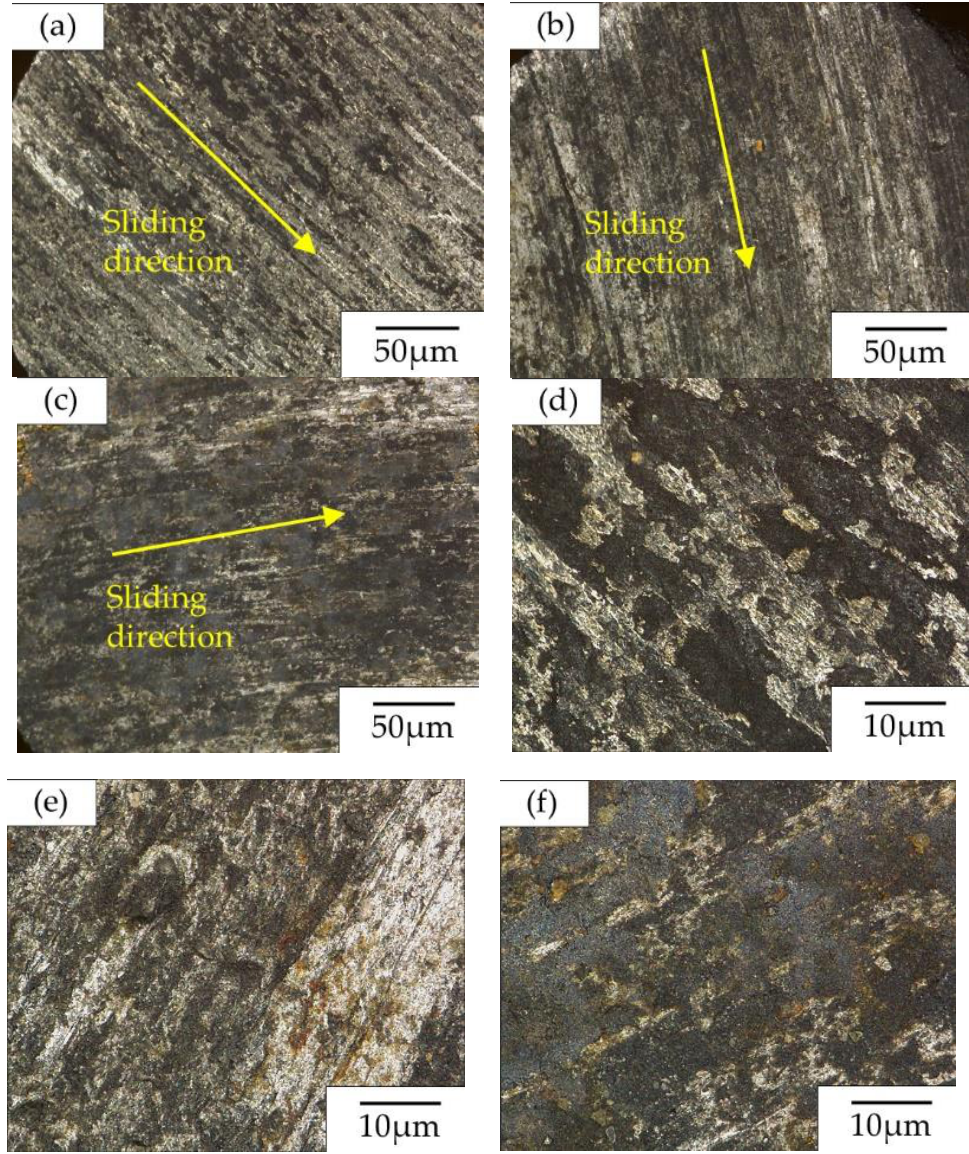
Figure 7. Micro morphologies of worn surfaces of the pin at different loads (300 r/min, loam, moisture 0): ( a , d ) load of 2 N; ( b , e ) load of 5 N; ( c , f ) load of 8 N.